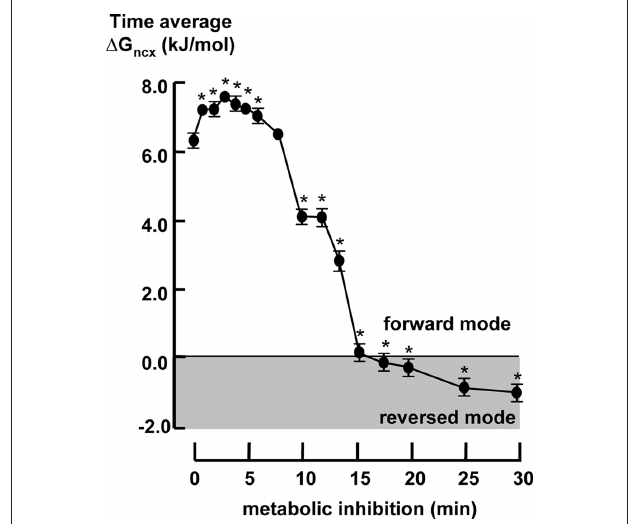
FiguRe 5 | The time averaged ∆ G in 2 Hz stimulated myocytes ( n = 20) exch during metabolic inhibition. All data expressed as mean ± SEM. * p < 0.05 versus Ctrl ( t = 0; one way